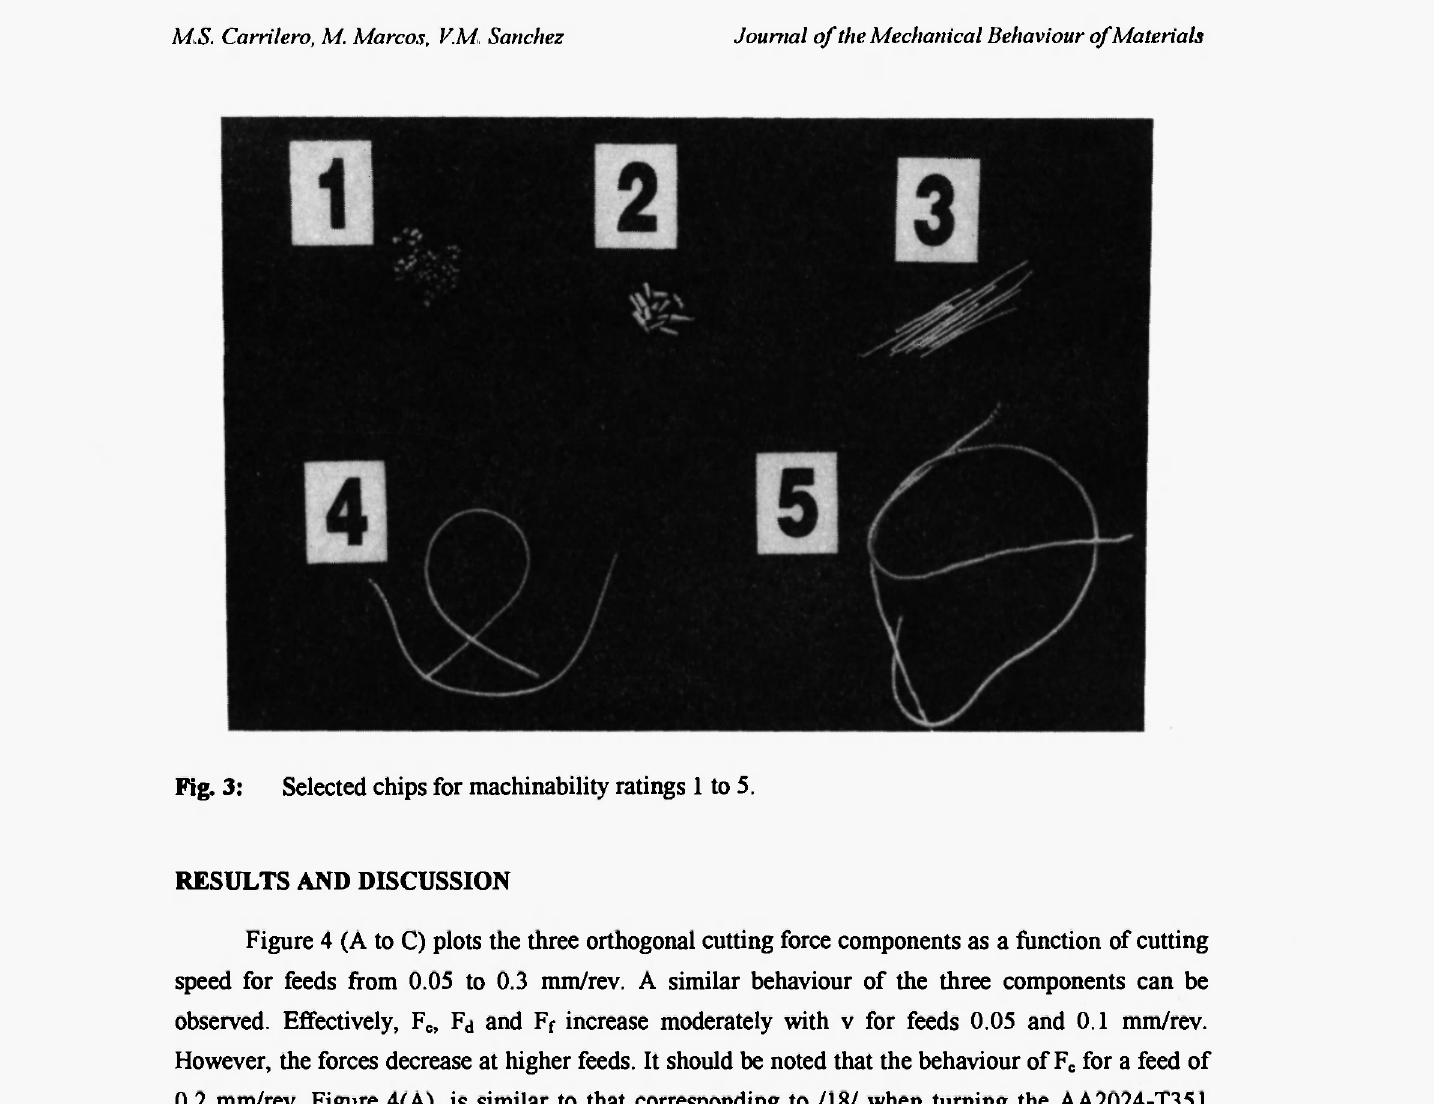
Fig. 3: Selected chips for machinability ratings 1 to